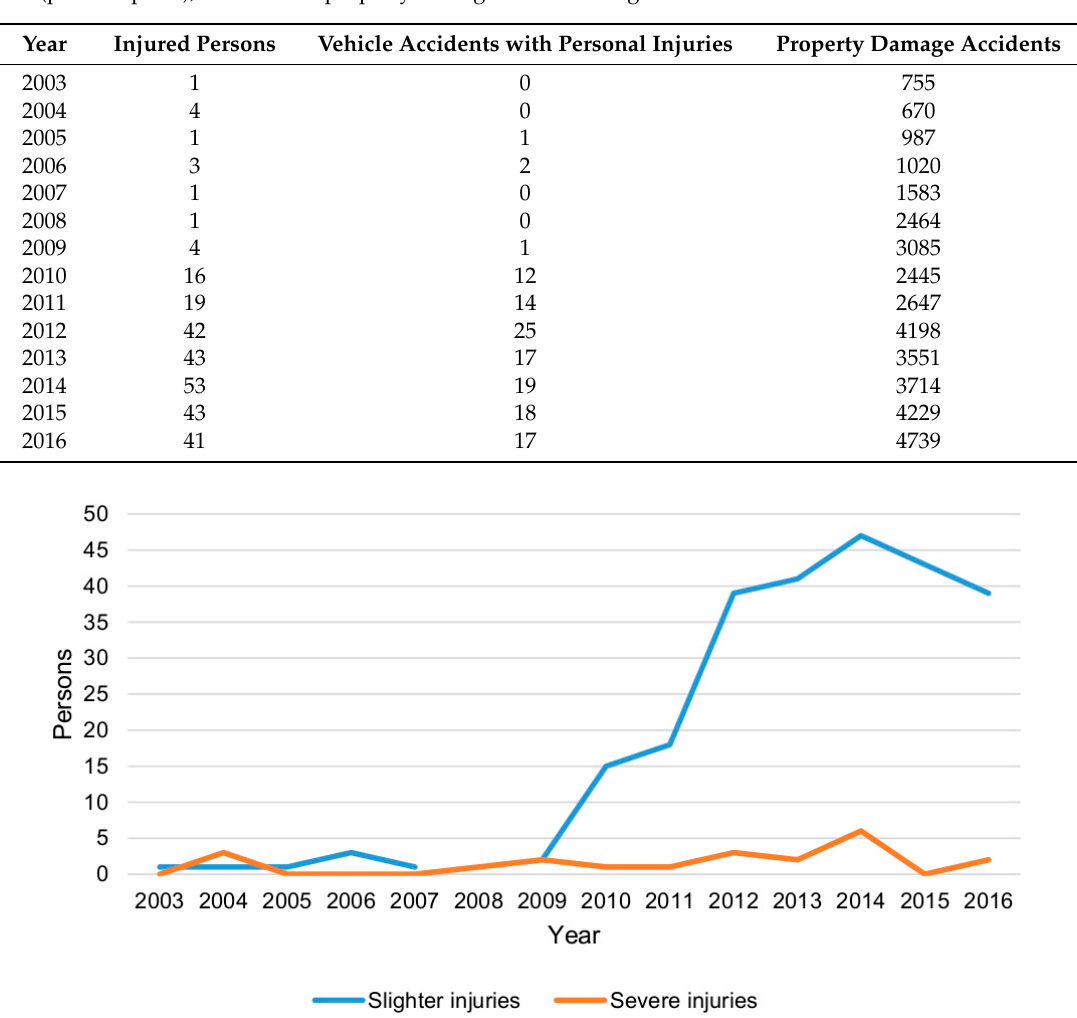
Table 2. Wild boar-vehicle accidents in Sweden from 2003 to 2016. The number of persons injured in accidents (severely and slightly injured), the number of vehicle accidents reported by the police, and the number of accidents with property damage. Data on injured persons originates from STRADA (police and hospital reports), data on vehicle accidents with personal injuries originate from STRADA (police reports), and data on property damage accidents originate from NVR.